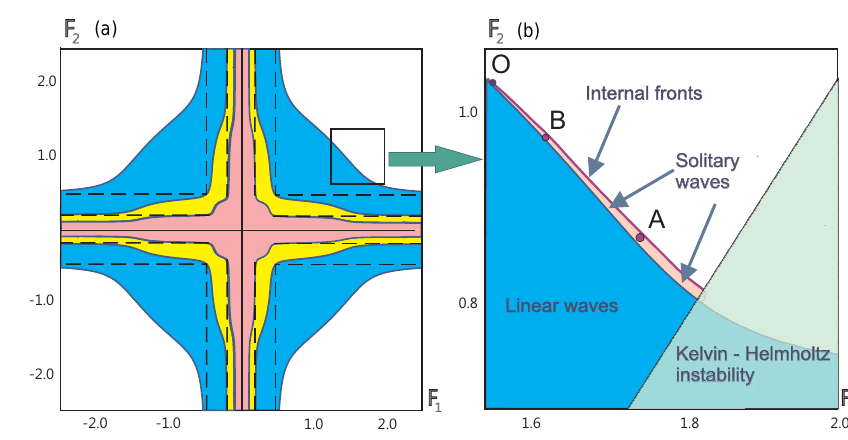
Figure 2. Spectrum of linear waves (coloured modes 1–3) (a) and fragment of the parametric domain of solitary waves (b) .